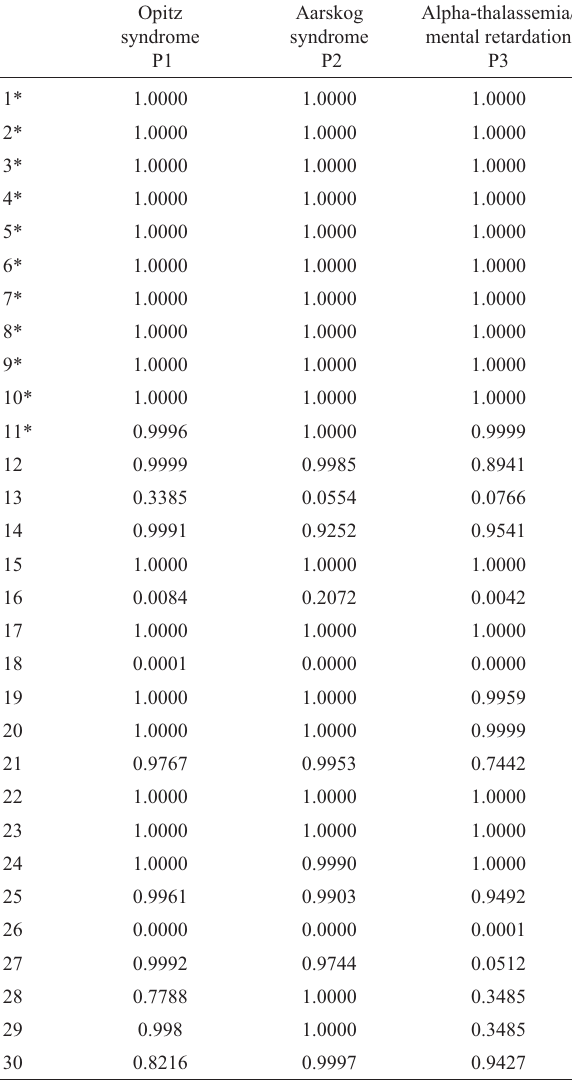
Table 5 - Probability figures favoring the hypothesis of SLOS in each of our 30 patients. Patients Probability figures favoring the diagnosis of SLOS relative